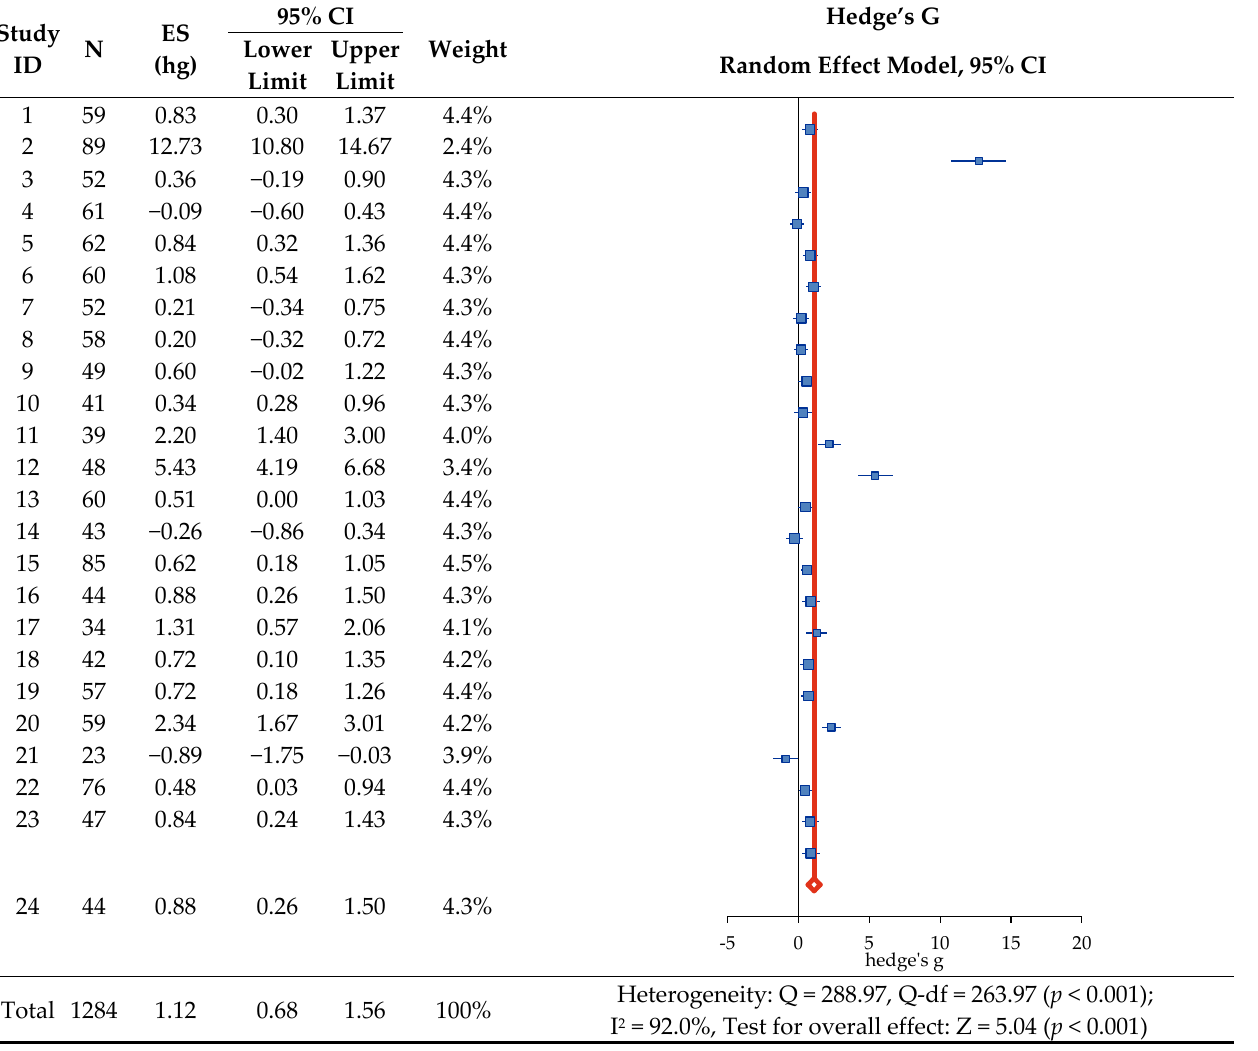
Figure 2. The effect of nurse support program on job satisfaction. Notes. ES: Effect size; CI: Confi- dence interval